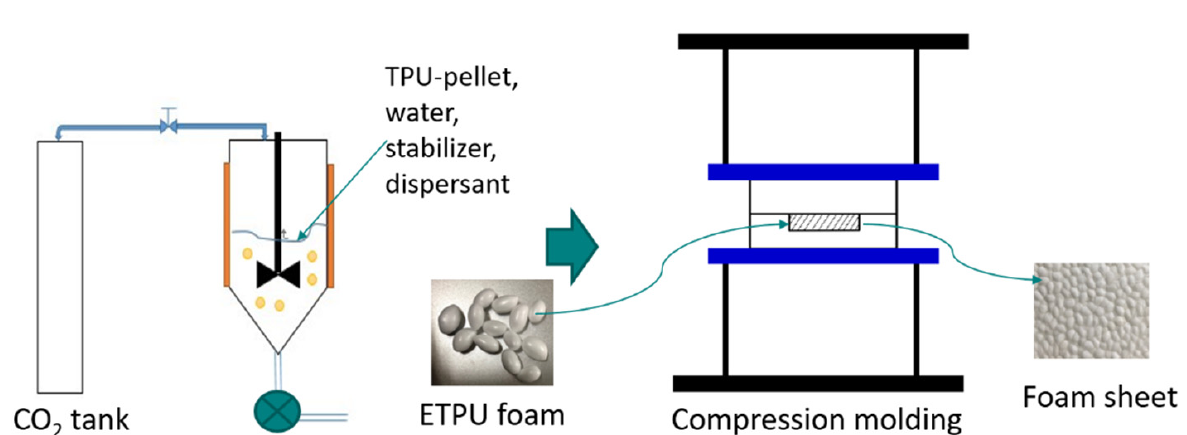
Figure 1. Schematic of the CO 2 assisted foaming process for preparing expanded thermoplastic polyurethane (ETPU) beads and the compression molding process.